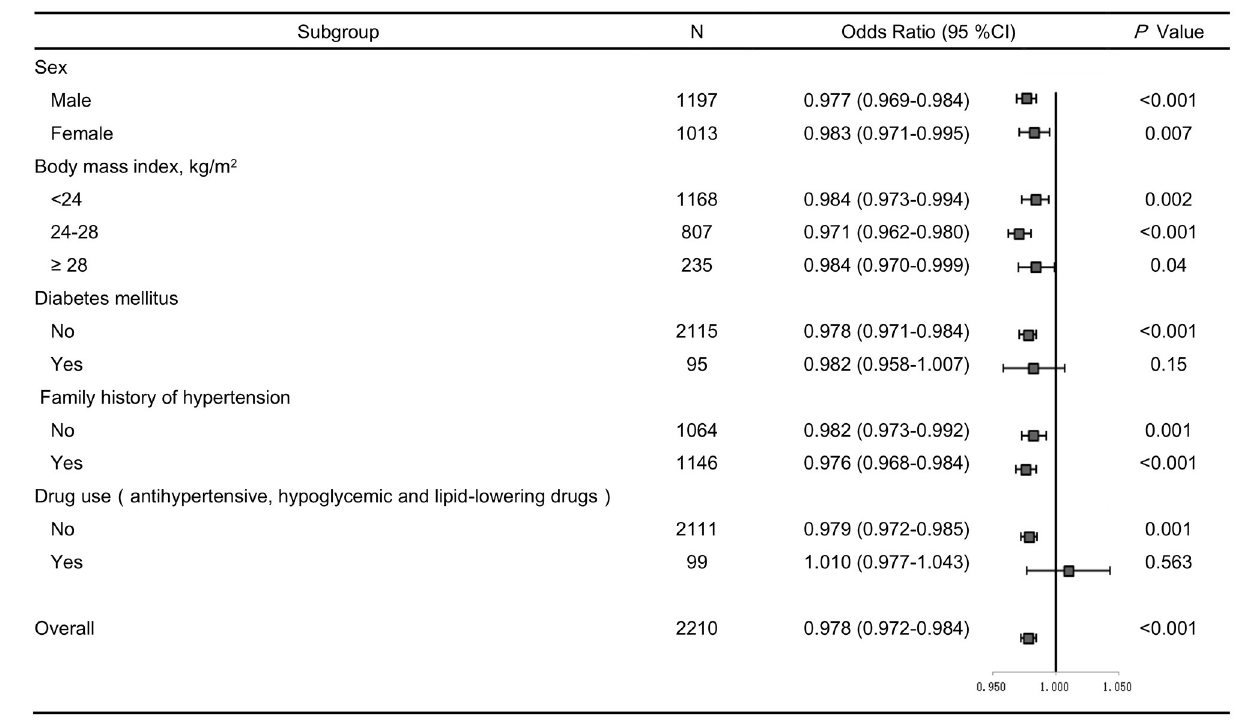
FIGURE 2 | Forest plots of odds ratios (ORs) for serum uromodulin and risk of hypertension after adjustment. The adjustment model includes age, smoke, BMI, serum creatinine, total cholesterol, triglycerides, fasting glucose in subjects stratified by sex, BMI, diabetes, family history of hypertension, and drug use. Values are the OR (95% confidence interval [95%